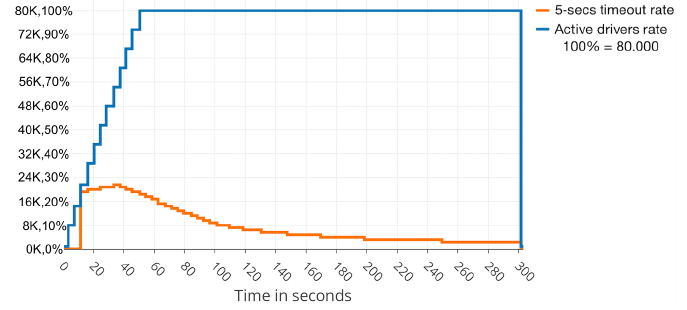
Figure 4. Slow responses percentage decreasing after rising to 26% with 38 KB message size.